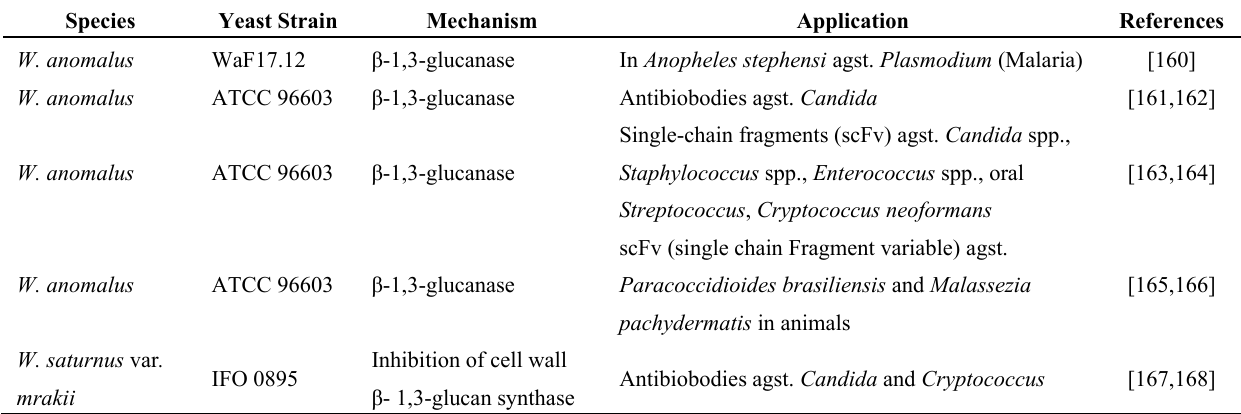
Table 3. Medical and veterinary applications of the most studied killer yeast strains and the mechanisms of